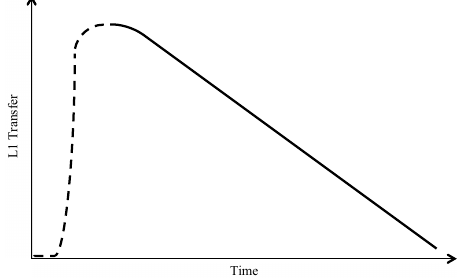
Figure 1. Schematic of the Transfer Ramp-up Hypothesis, showing L1 transfer over time in L2 development. The dotted part of the curve indicates the pre-ramp-up stage and ramp-up to maximal L1 transfer; the solid part, the post-ramp-up stage of declining L1